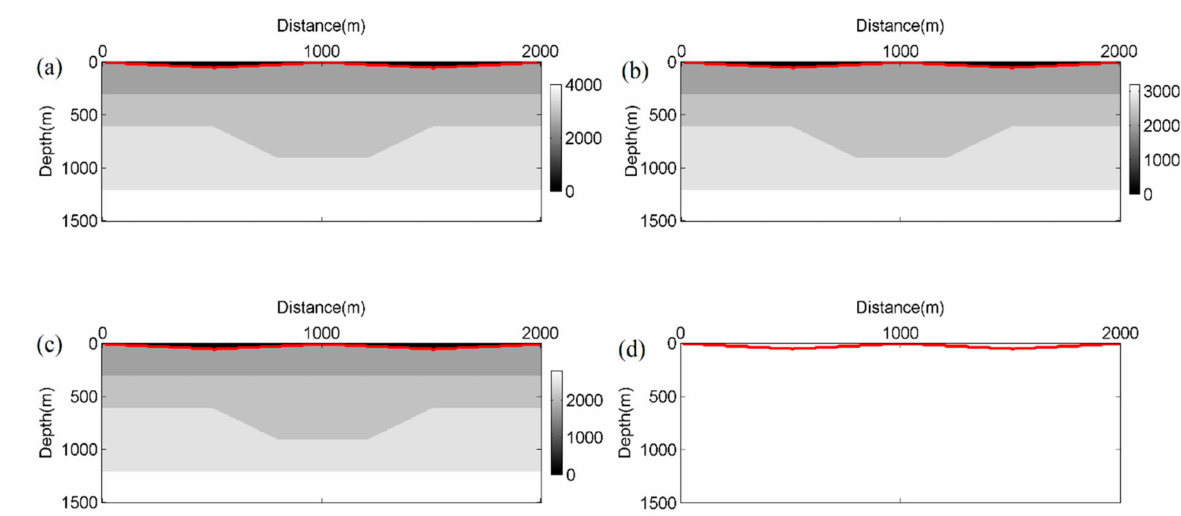
Figure 4. Graben elastic model with a triangular topography: ( a ) V p model, ( b ) V s model, ( c ) ρ model, and ( d ) surface topography of the model. The red line is the surface